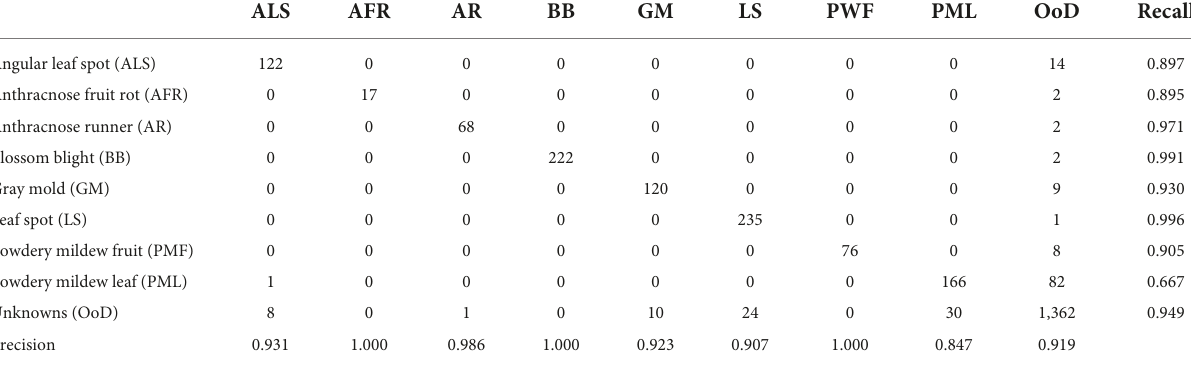
TABLE 4 Confusion matrix of the final two-head network